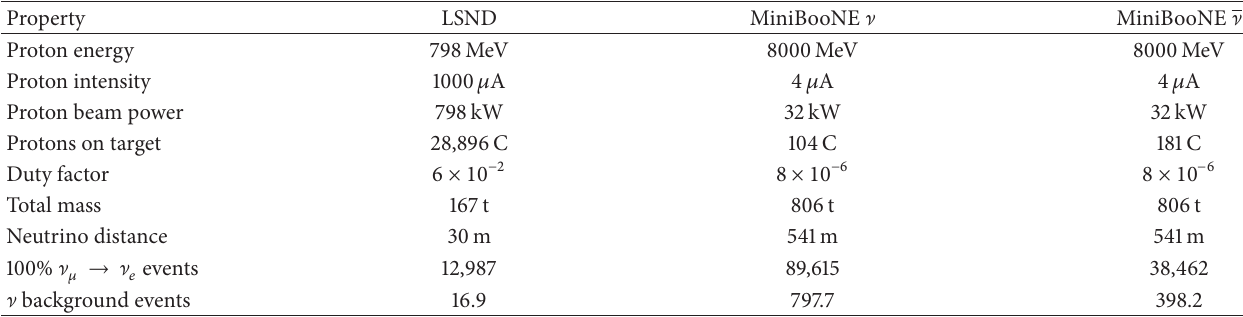
Table 1: The main characteristics of the LSND and MiniBooNE experiments. Also the estimated number of neutrino background events and signal events for 100% ] 𝜇 → ] 𝑒 transmutation are shown. The 𝑅 𝛾 > 10 requirement is assumed for the LSND events.